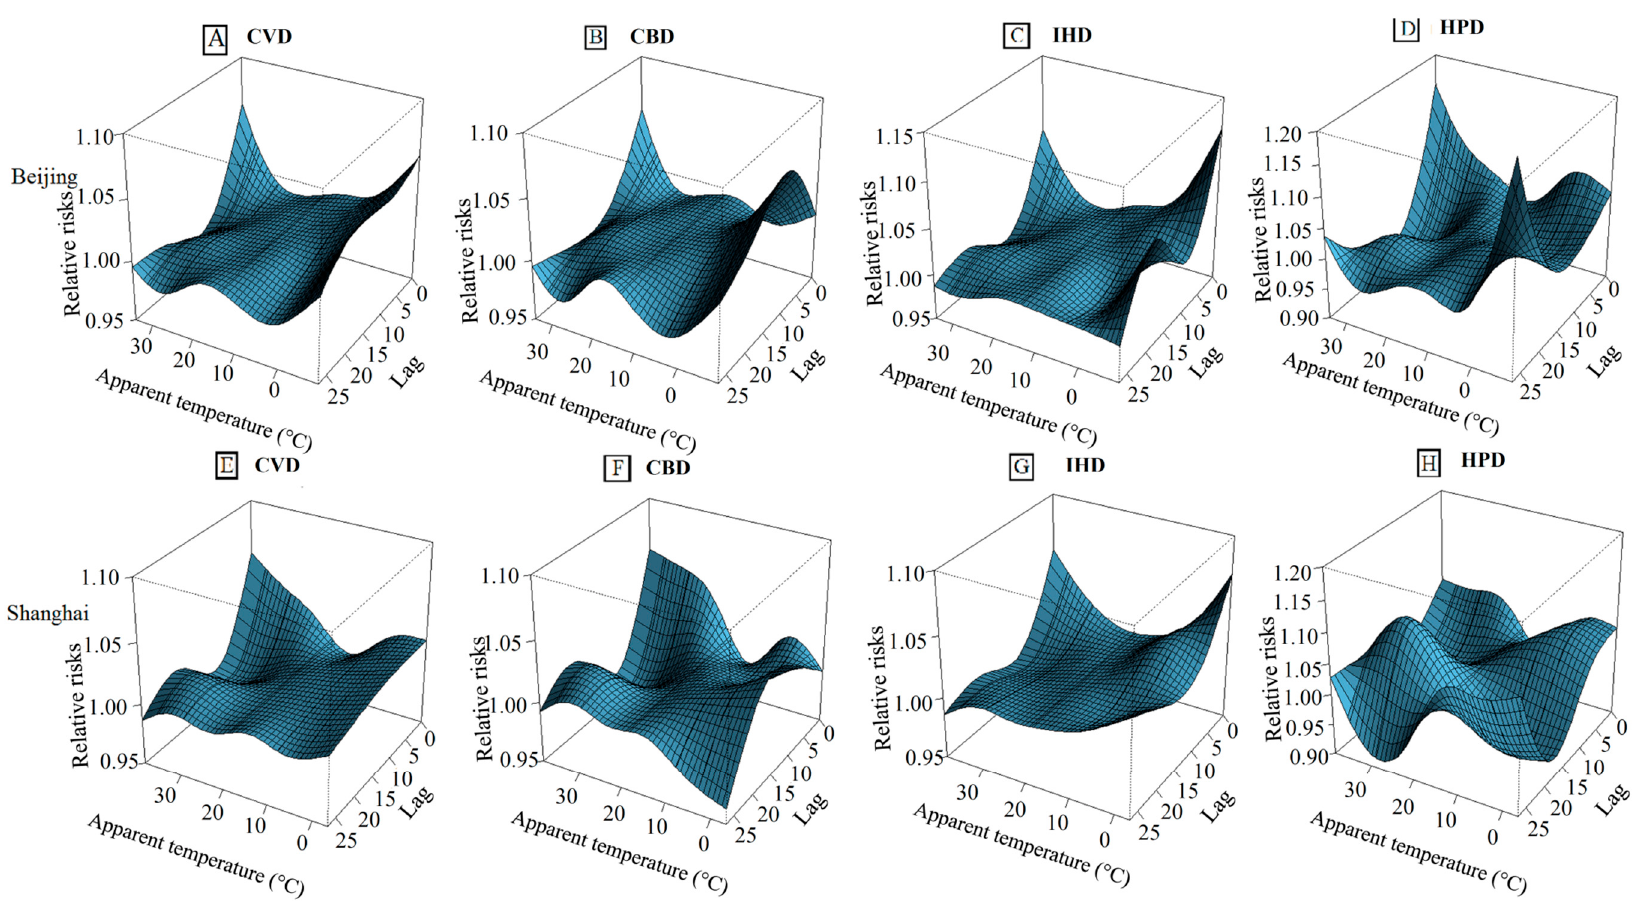
Figure A3. Three-dimensional graph of the relative risks for cause-specific cardiovascular disease by apparent temperature (°C) and lag days during 2007 and 2009 in Beijing and Shanghai, China. ( A – D ) The relative risks for CVD, CBD, IHD and HPD mortality in Beijing, respectively. ( E – H ) The relative risks for mortality from CVD, CBD, IHD and HPD mortality in Shanghai, respectively.